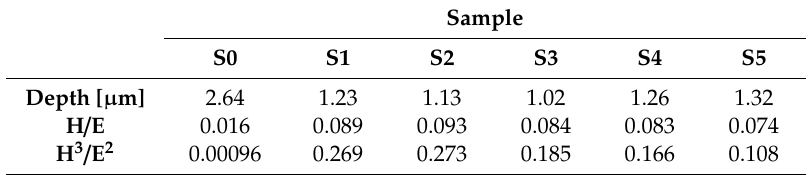
Table 7. Comparison of the depth [groove] and H / E ratio on samples tested at 15 N load and 15